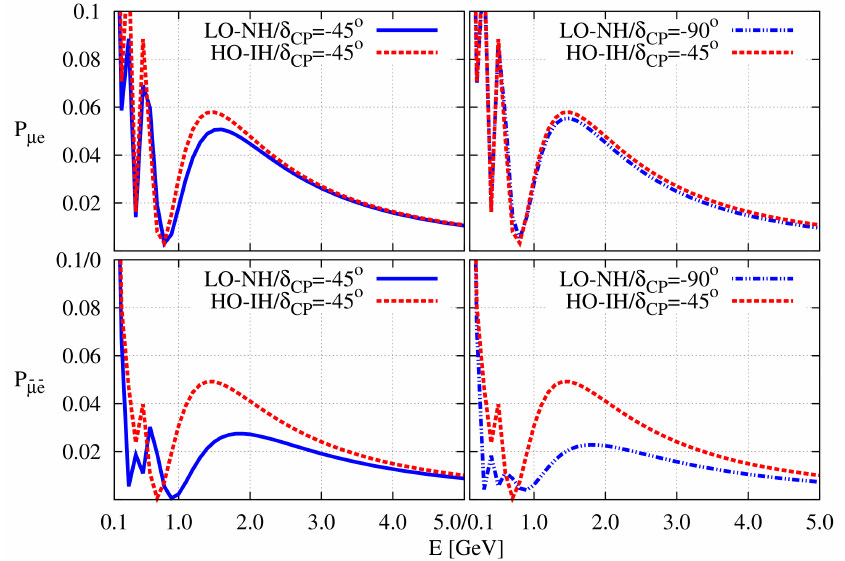
Figure 2. Illustration of degenerate P µ e and non-degenerate P ¯ µ ¯ e for the following two cases. Left : (LO-NH, δ CP = − 45 ◦ ) and (HO-IH, δ CP = − 45 ◦ ). Right : (LO-NH, δ CP = − 90 ◦ ) and (HO-IH, δ CP = − 45 ◦